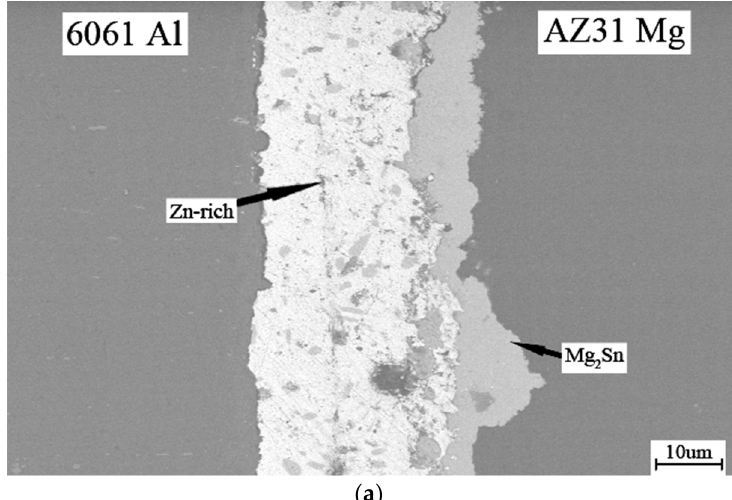
( a ) ( a ) Figure 9. Cont